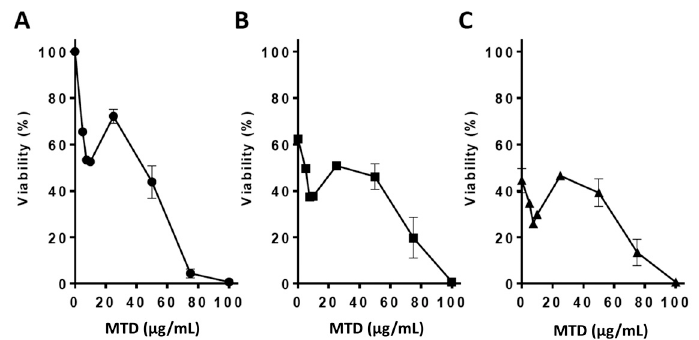
Figure 1. Cytotoxicity of methadone (MTD) on LN229 cells without and with co-treatment with temozolomide (TMZ). ( A ) Viability of LN229 cells, measured by the MTT assay, as a function of MTD concentration in the medium. ( B ) Viability of LN229 cells treated with 20 µM TMZ and ( C ) 75 µM TMZ and increasing concentrations of MTD. The MTT assay was performed 96 h after the addition of MTD to the medium. Data are the mean of three independent experiments.